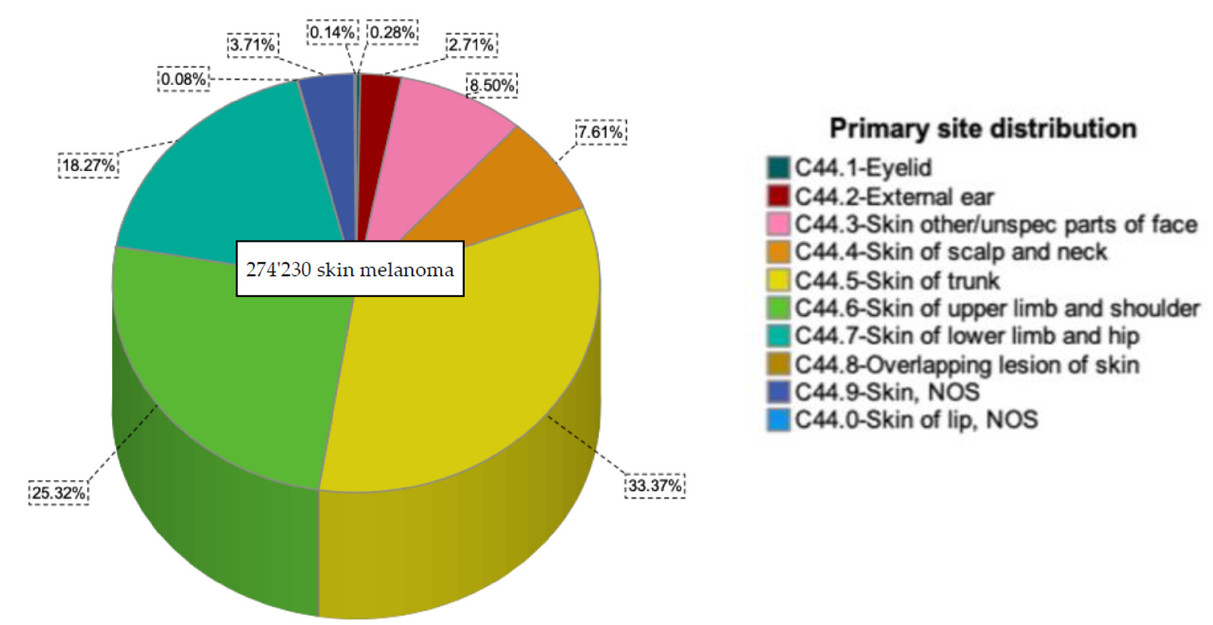
Figure 1. Melanoma distribution according to the primary site. Table 1. Demographic, pathological, and treatment characteristics of the study population.